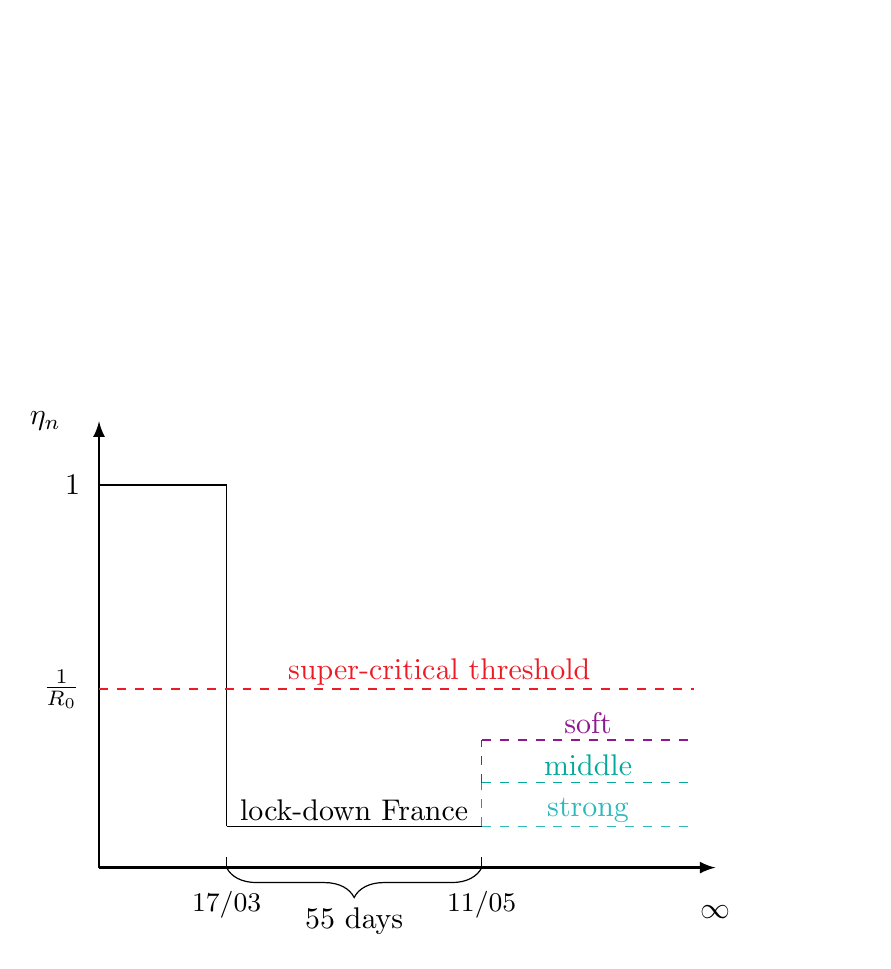
Figure S1 – Variation of the contact rate ( η t ) for the estimation of the time to extinc- tion ( τ ). On Mar 17 a lock-down was instated in France. We estimated its efficacy to be 0.76 (Sofonea et al., 2020). The lock-down officially ended on May 11, for around 1- η t “ a total of 55 days under full lock-down. We evaluated the time to reach extinction under various extension constraints by assuming an infinite lock-down prolongation with fixed intensity, potentially different from the value estimated during the Mar 17 and May 11. The intensity of the lock-down/extension is inversely proportional to the contact rate ( η t